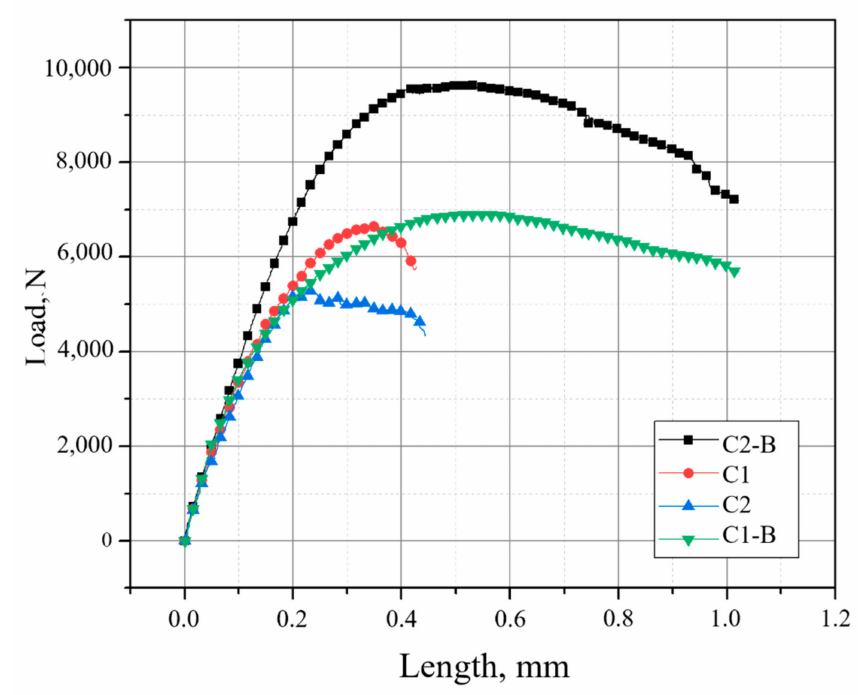
Figure 11. Load versus length curves of the CP lap welded